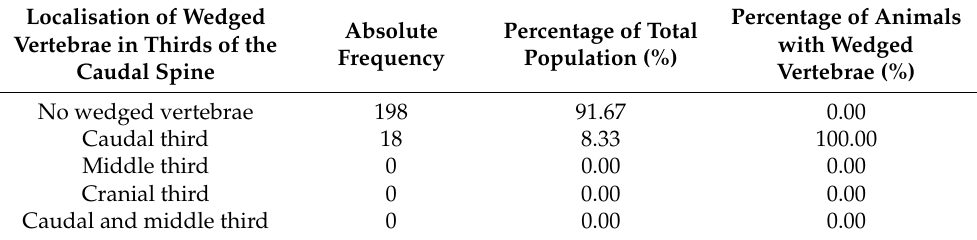
Table 3. Frequency and localisation of wedged vertebrae within the caudal spine of lambs. Localisation of Wedged